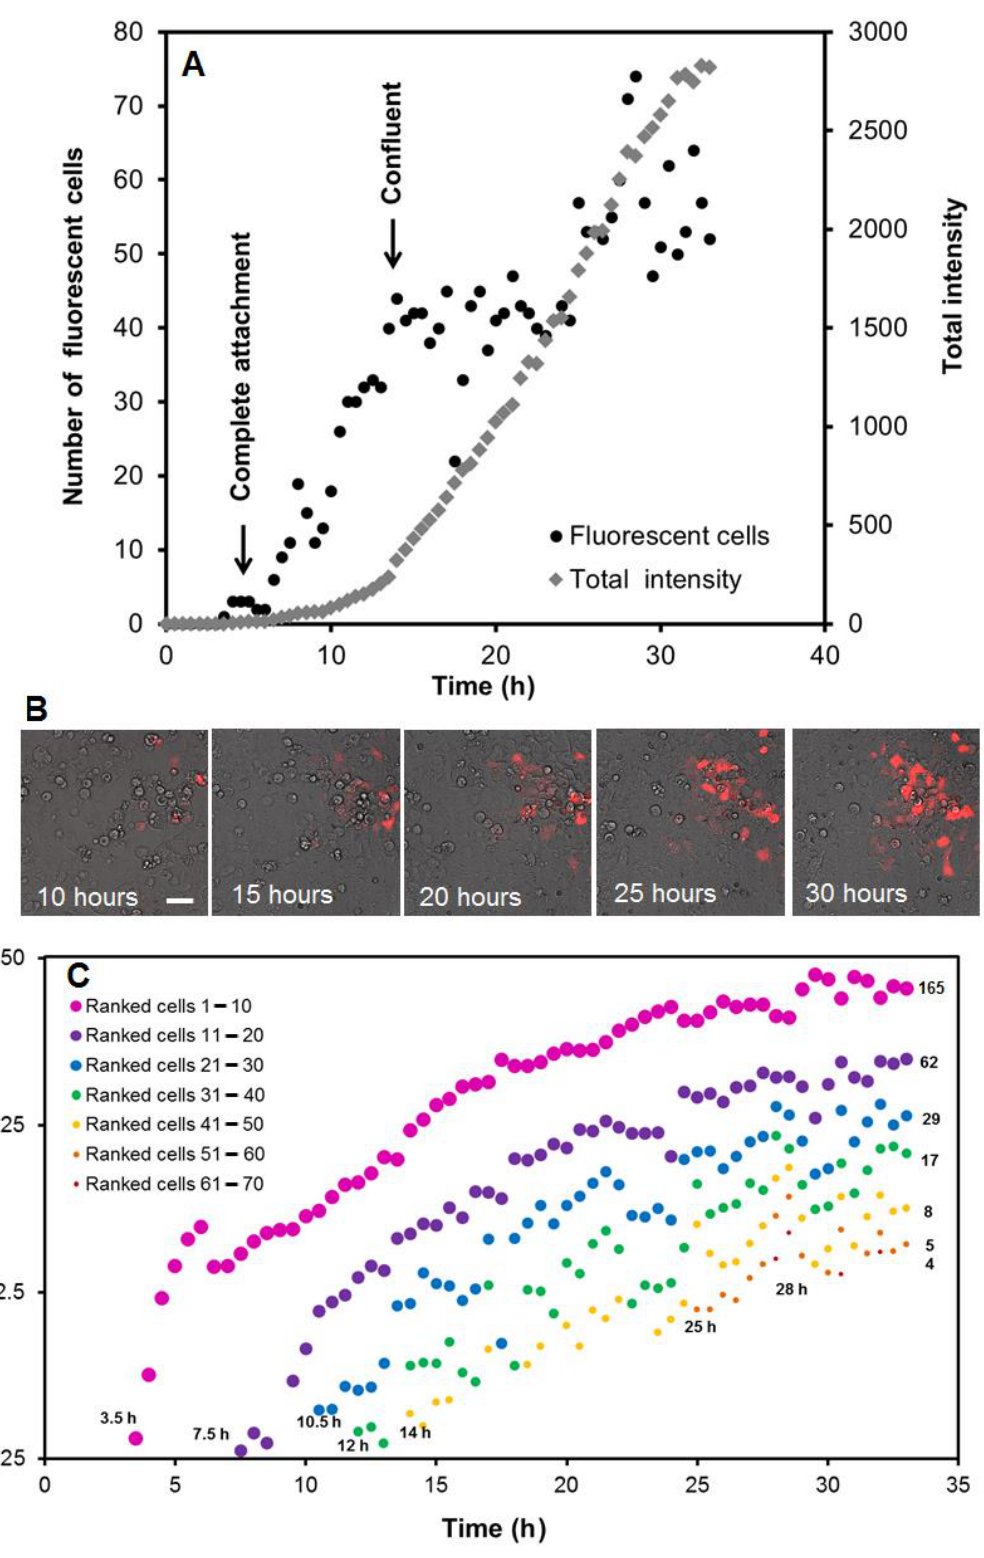
Figure 2. Time course of RFP expression after reverse transfection. ( A ) Graph of the number of fluorescent cells (left axis, black dots) and the total fluorescence of all cells (right axis, open diamonds) in time. Based on bright field images, the complete cell attachment and the moment when complete confluence of the cell layer was reached are indicated in the figure. ( B ) Overlay of bright field and RFP fluorescence at 10, 15, 20, 25 and 30 h after inoculation. Scale bar = 50 µm. ( C ) Graph of the average intensity within pools of ranked fluorescent cells over the time course of the reverse transfection. The pools represent up to 10 fluorescent cells ranked from the highest to lowest expressing cells at each timeframe. The start time of each pool is indicated in the graph, and the average intensity of the pool at 33 h post transfection is shown on the right within the